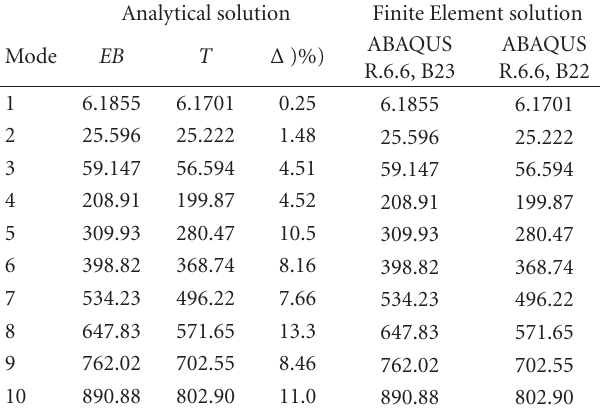
Table 9: First ten natural frequencies (Hz); see Table 7; θ 2,3 = − 45 ◦ ,90 ◦ . Analytical solution